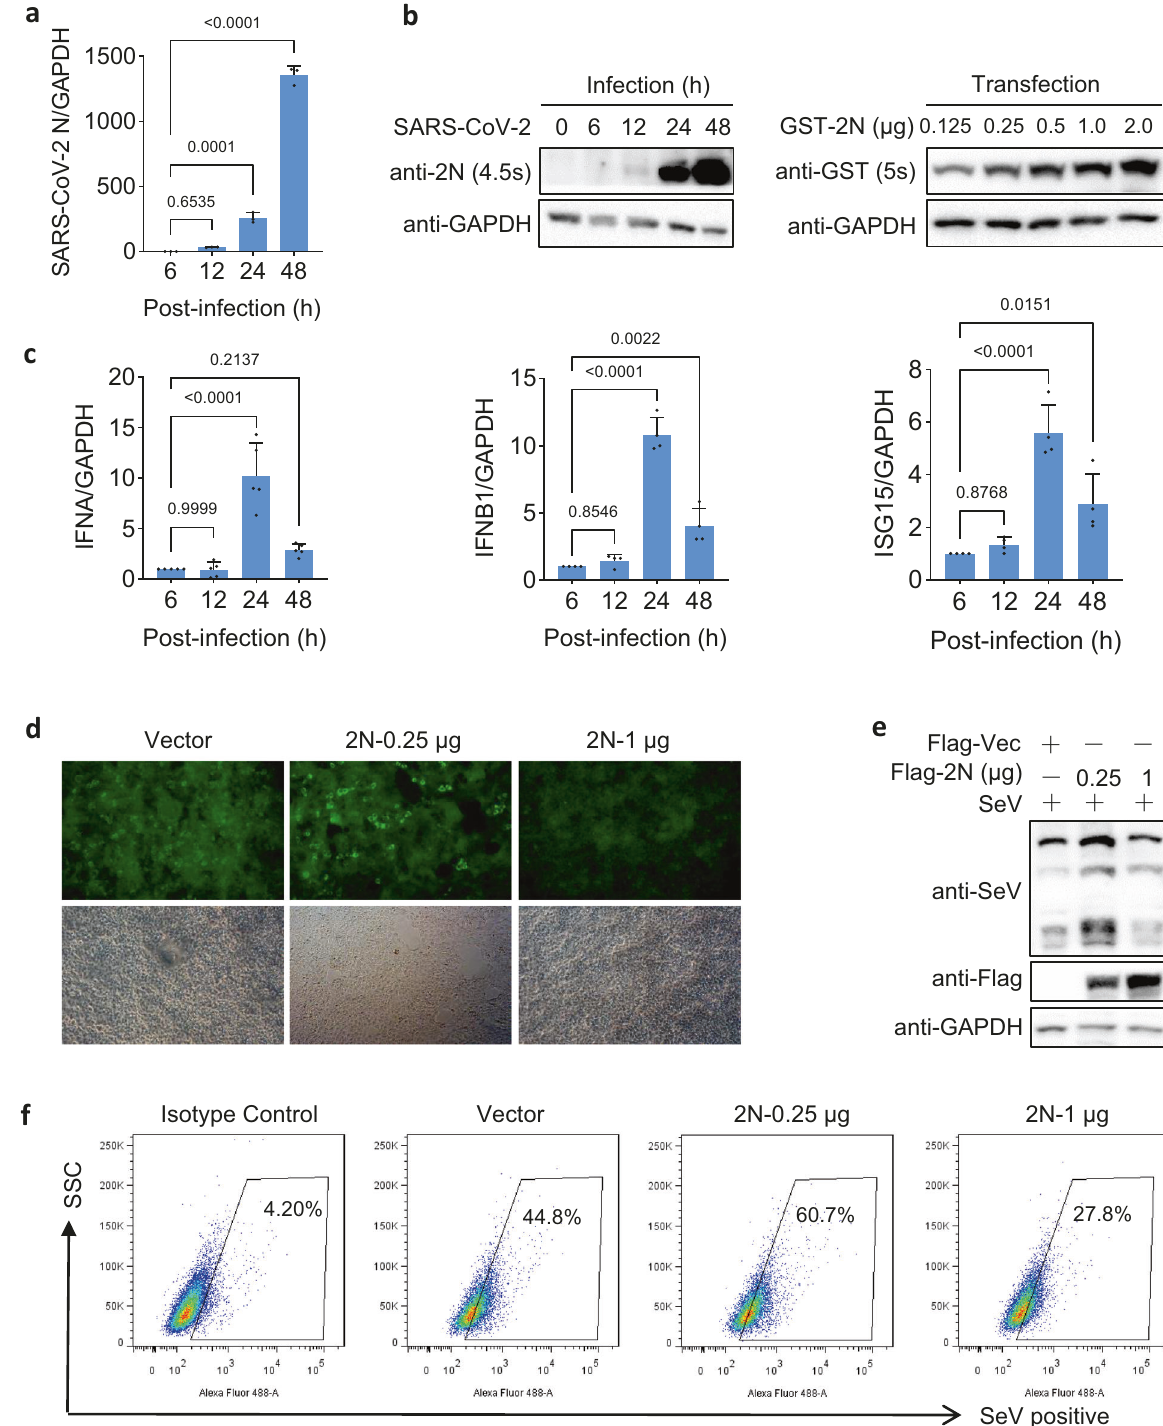
Fig. 8 SARS-CoV-2 N protein dually regulates viral replication. a , c Caco-2 cells were infected with SARS-CoV-2 at MOI of 0.01. At 6, 12, 24, and 48 hpi, total RNA was extracted. The mRNA expression of the viral N gene ( a ) and host IFNA, IFNB1, ISG15 ( c ) relative to GAPDH control were examined using qPCR. b Caco-2 cells were infected with SARS-CoV-2 as indicated as in a , HEK293T cells were transfected with the indicated 2N plasmids. At 24 hpt, and lysis of infected and transfected cells (50 μ g/sample) were analyzed by immunoblot. d – f The HEK293T cells were transfected with 2N plasmids as indicated. The cells were infected with SeV at 24 hpt. After 20 h, cells were analyzed with immuno fl uorescence (Scale bar, 100 μ m) ( d ), immunoblot ( e ), and fl ow cytometry ( f ). Results shown are the mean ± SD of at least three independent